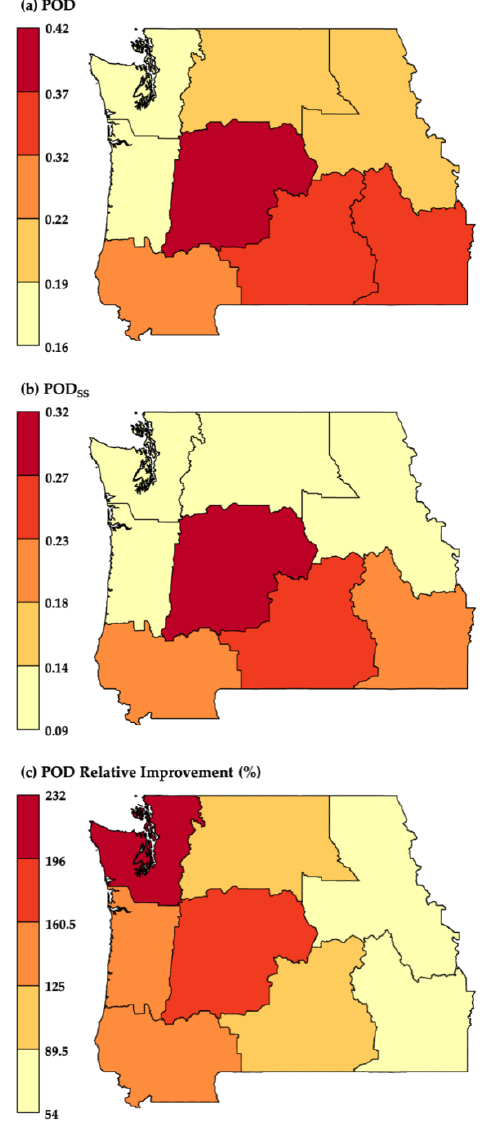
Figure 4. Red Flag Warning skill for large fire days ( ≥ 90th percentile) for each WFO showing ( a ) POD, ( b ) POD SS , and ( c ) relative improvement over the random climatology reference forecast.